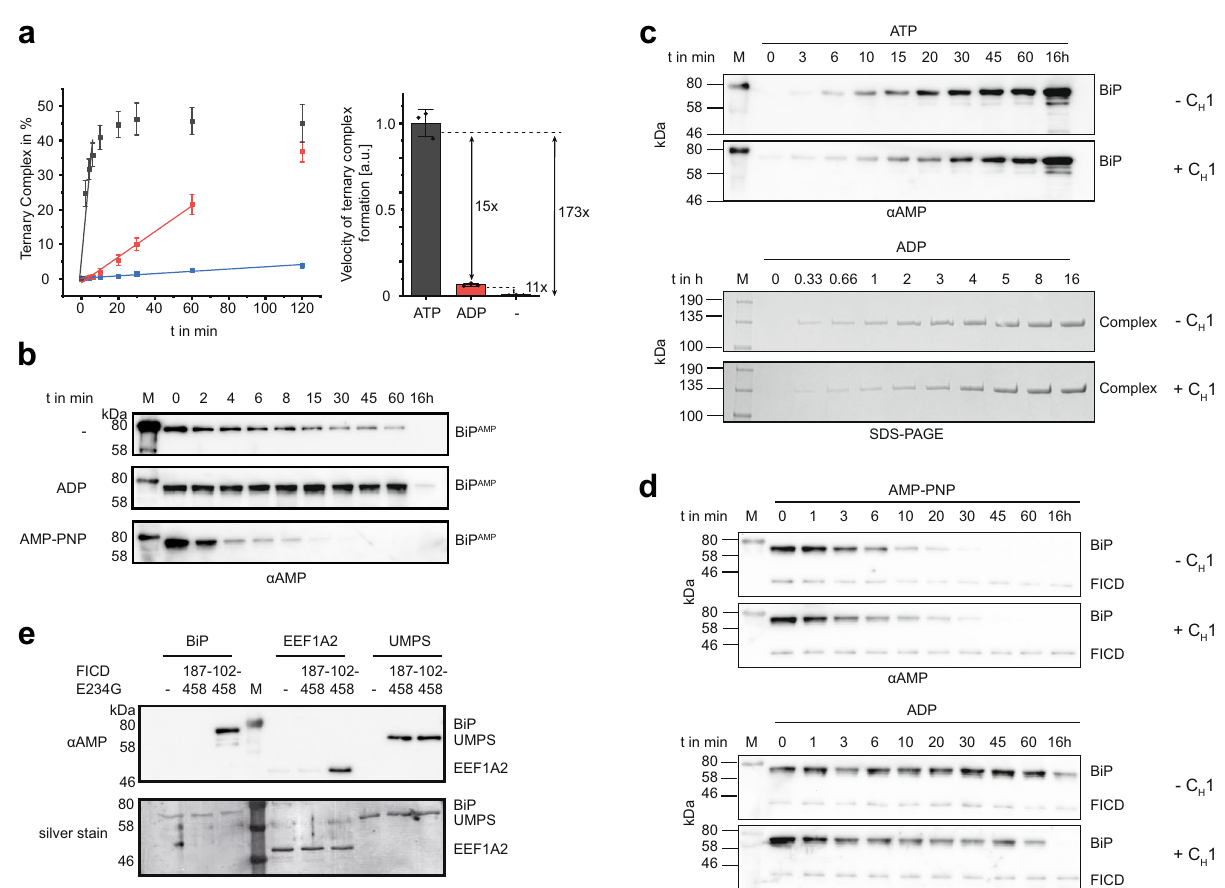
Fig. 4 Effect of nucleotides, unfolded proteins, and TPR motifs on FICD-mediated AMPylation and deAMPylation. a Ternary complex formation of FICD TReND-2 (102 – 445 E234G E404C) and BiP 19 – 654 as readout for the AMPylation of BiP in the presence of ATP (gray) and ADP (red) (both at 0.5 mM) or the absence of any nucleotide ( − , blue). The reaction progress was monitored via SDS-PAGE and quanti fi ed by densitometric analysis. The experiment was performed in three independent replicates. Data are presented as mean values + / − standard deviation The bar chart represents the relative mean value + / − standard deviation of the linear slope. Full gels are shown in Supplementary Fig. 11. b FICD 102 – 458 WT mediated deAMPylation of BiP AMP 19 – 654 in the presence of ATP and ADP (both at 1 mM) or the absence of any nucleotide ( − ) was monitored via western blotting with an α